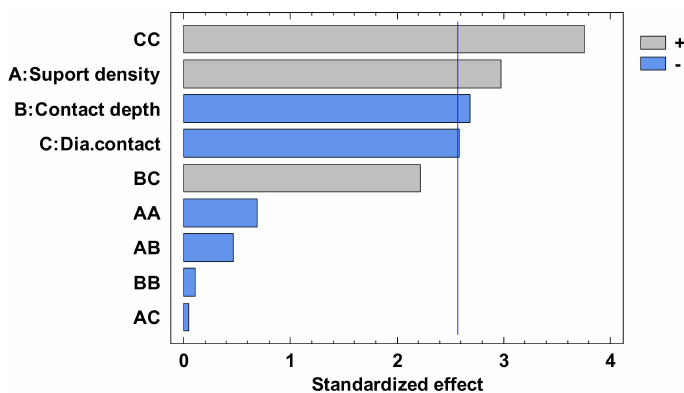
Figure 30. Standardized Pareto Chart for Roundness Hole_15.